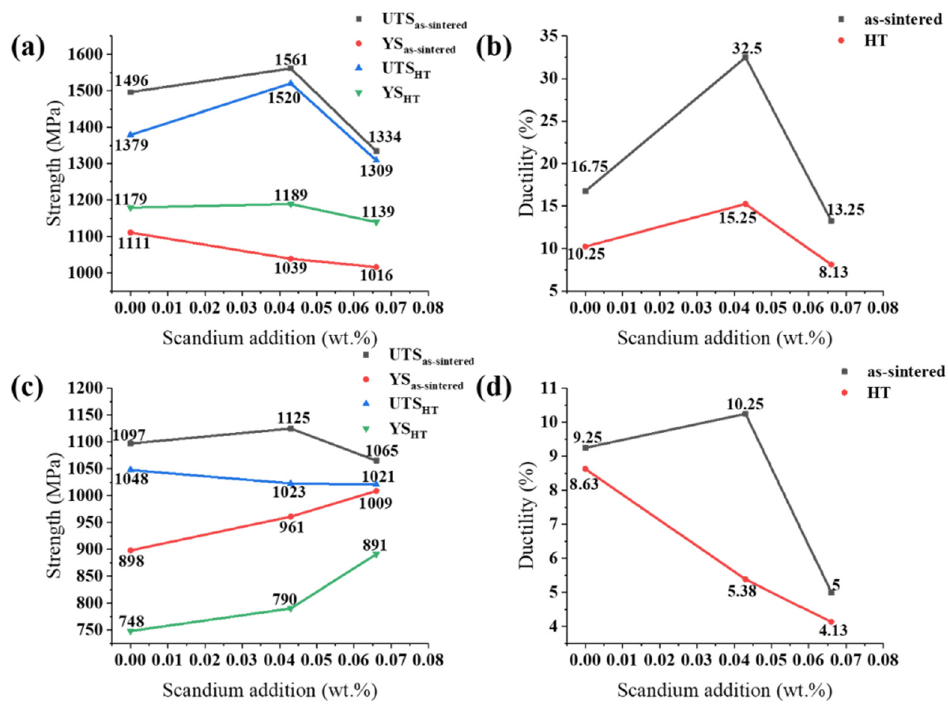
Figure 15. Tensile properties at 25 °C and 750 °C of Sc-doped U720Li under di ff erent conditions: ( a , b ) 25 °C, ( c , d ) 750 °C.